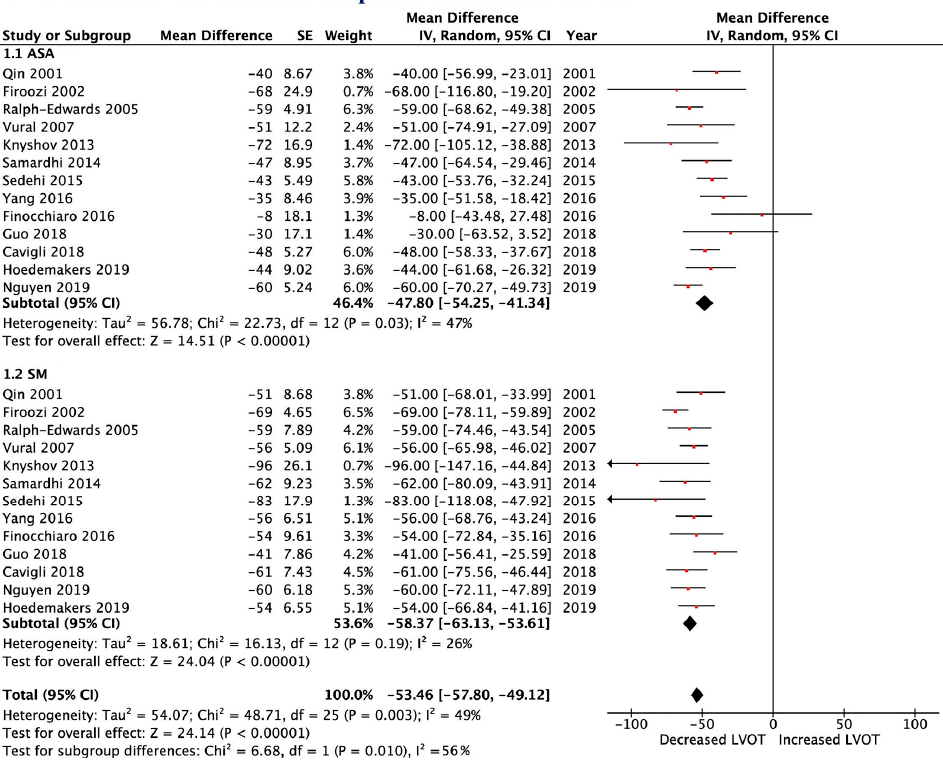
Figure 5. Left ventricular outflow tract (LVOT) gradient mean change; (1.1 ASA) ASA group; (1.2 SM) SM group. ASA, alcohol septal ablation; SM, surgical myectomy; CI, confidence